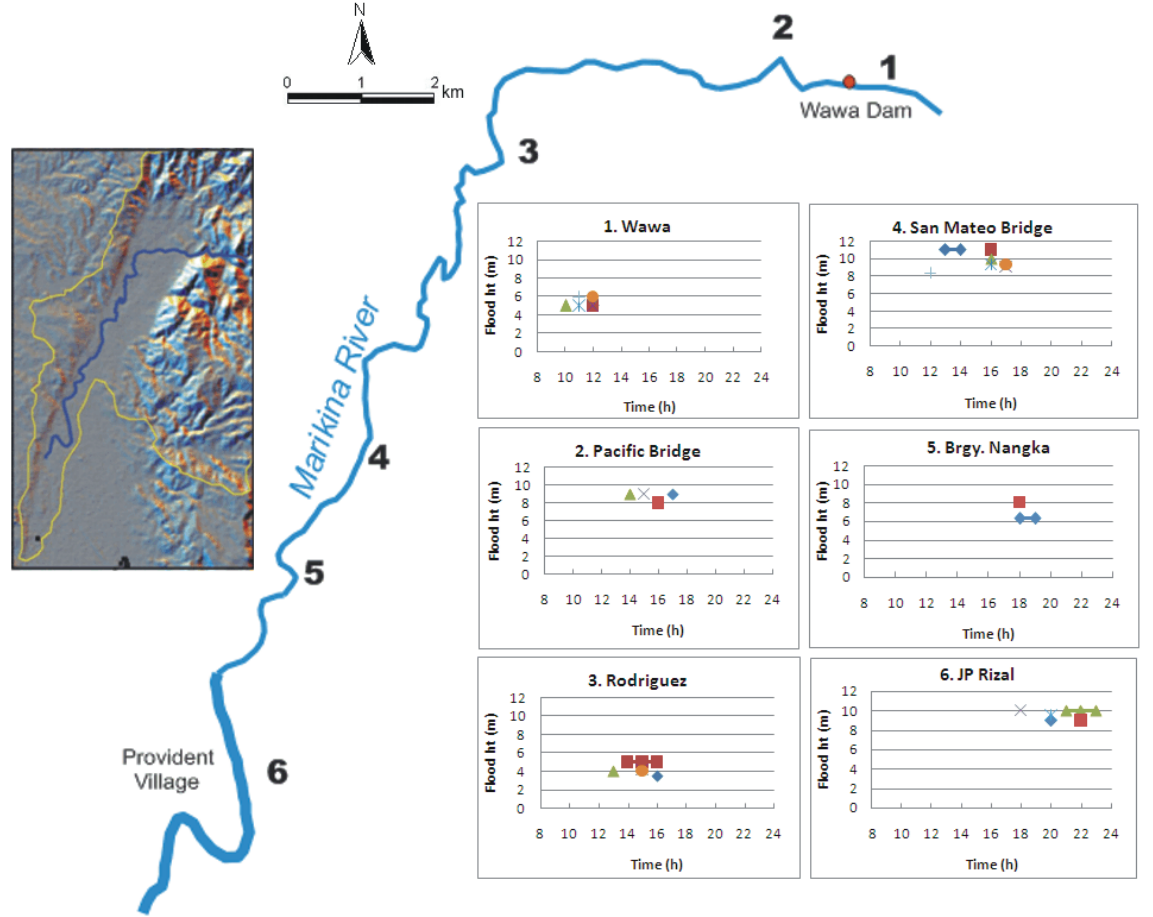
Fig. 2. Anecdotal accounts of the time of peak flooding in various points along the Marikina River.